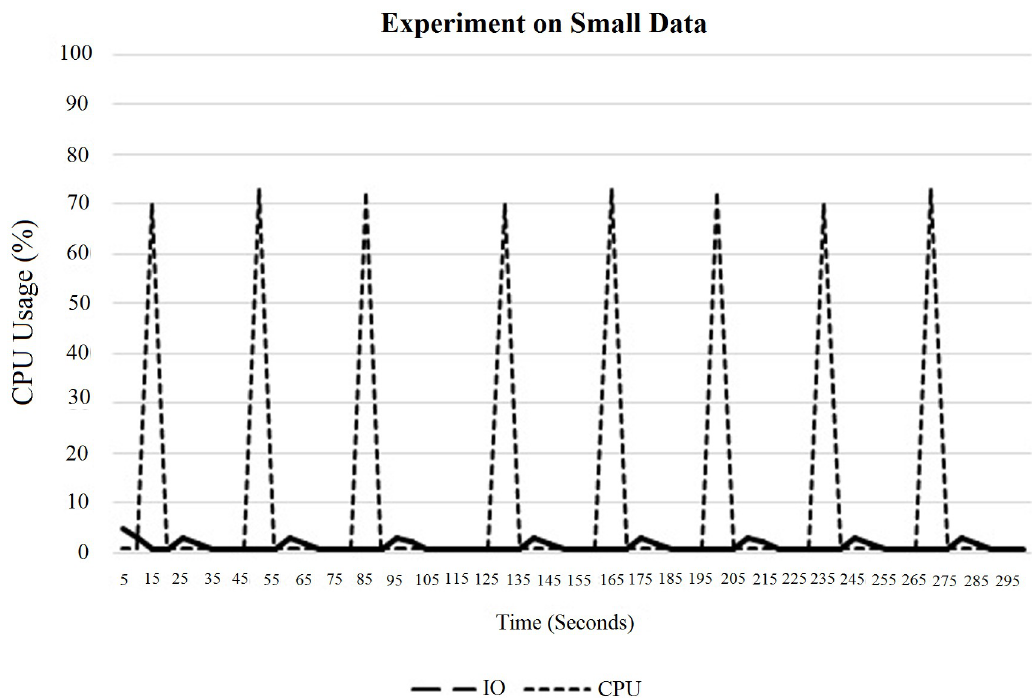
Fig 18. CPU and IO usage for a single DataNode using small